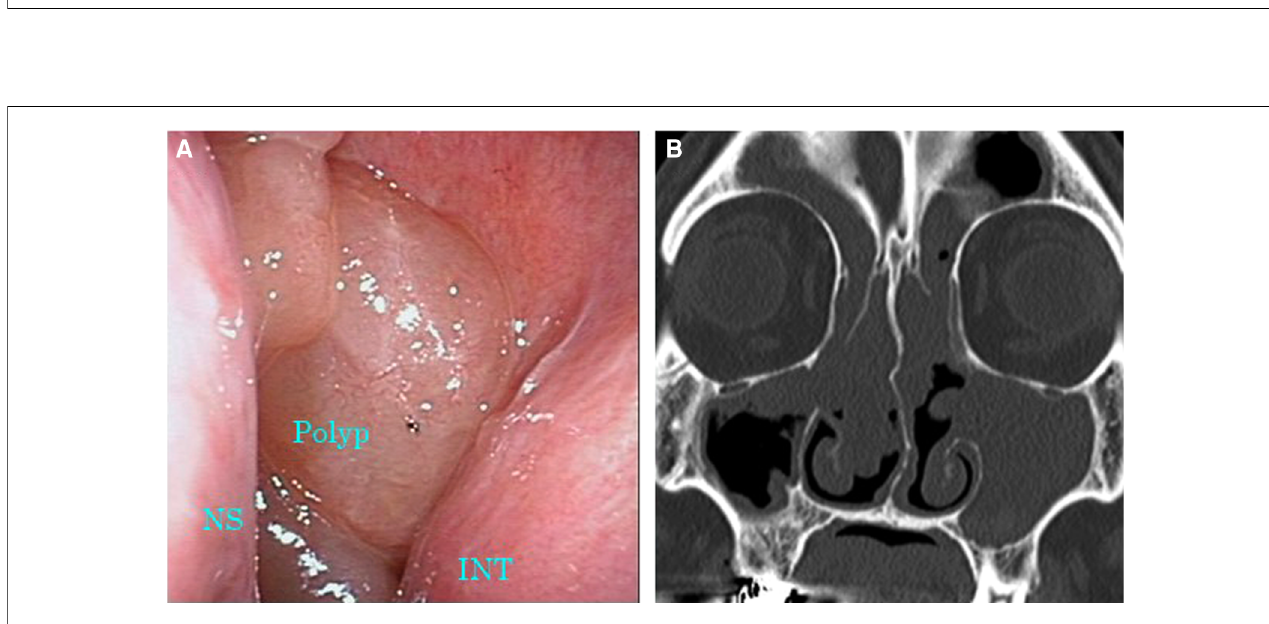
FIGURE 2 Images of nasal endoscopy and sinus CT before initiation of dupilumab therapy. ( A ) Nasal polyps occupying the common nasal meatus were observed. ( B ) Soft tissue density lesions were fi lling all sinuses on both sides. CT, computed tomography; INT, inferior nasal turbinate; NS, nasal septum.